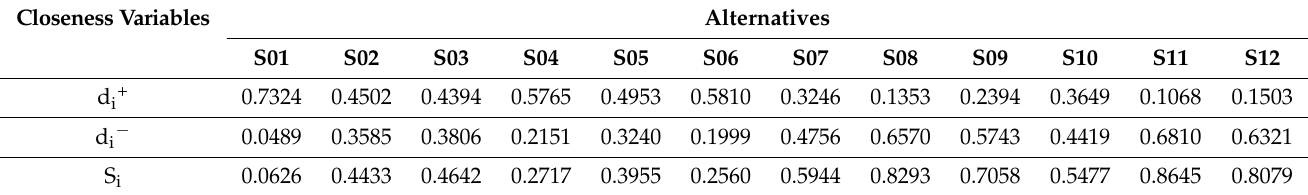
Table 8. Closeness coefficients (S i ) of the alternatives (data were supplemented with intermediate values—distances d i+ , d i − ). Closeness